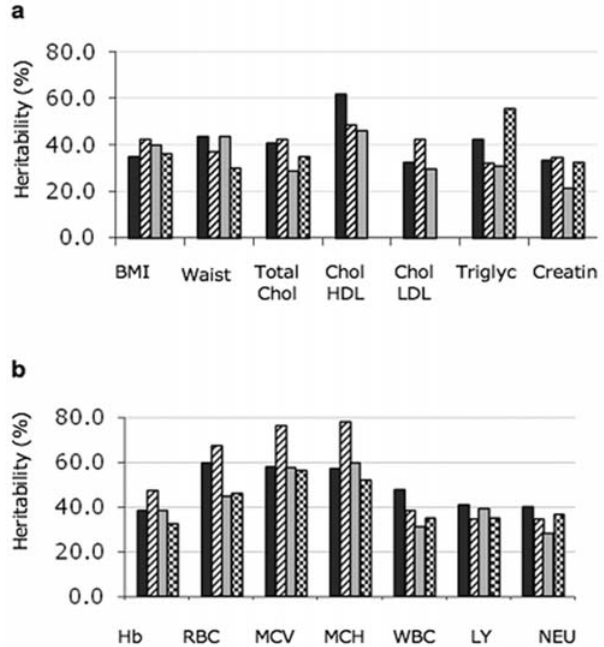
Figure 6. Comparison of the heritability of different genetic isolates from Italy. a. anthropometric and lipid measures. B: blood measures. The traits are indicated along the X-axis. Black bar: Val Borbera; dashed bar: Lanusei; grey bar: Cilento; checkered bars: Carlantino. Abbreviations are as in table 1 and 2. doi:10.1371/journal.pone.0007554.g006 PLoS ONE |